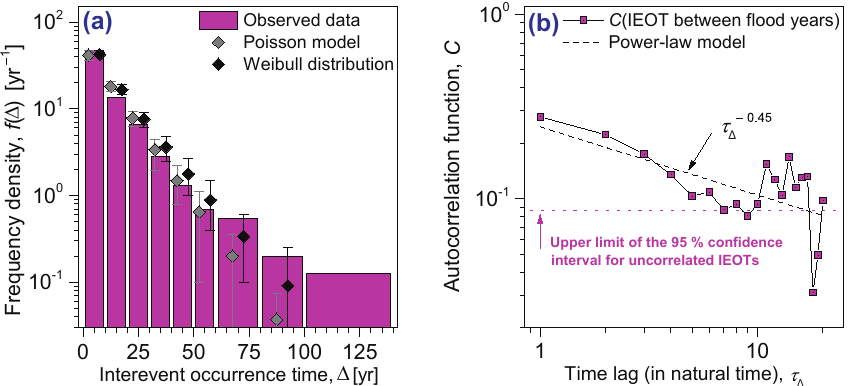
Figure 7. Frequency-size and autocorrelation analysis of the interevent occurrence times (IEOTs) and comparison to the Poisson model. (a) Frequency density of the IEOTs between the flood years given as a function of IEOTs in years (pink vertical bars, semi-logarithmic scale), the corresponding best-fit Poisson model (grey diamonds) (Eq. 2) which was considered in Fig. 6, and the best-fit Weibull distribution (black diamonds) (Eq. 3), both with 95% confidence intervals. (b) Autocorrelation function (Eq. 5) of the IEOTs between flood years (those years with n ≥ 1 flood). Also given is the best-fitting power-law model (dashed black line) (Eq. 14) and the upper limit of the 95% significance for the autocorrelation function of a non-correlated time series with the same one-point probability distribution (horizontal dotted line,